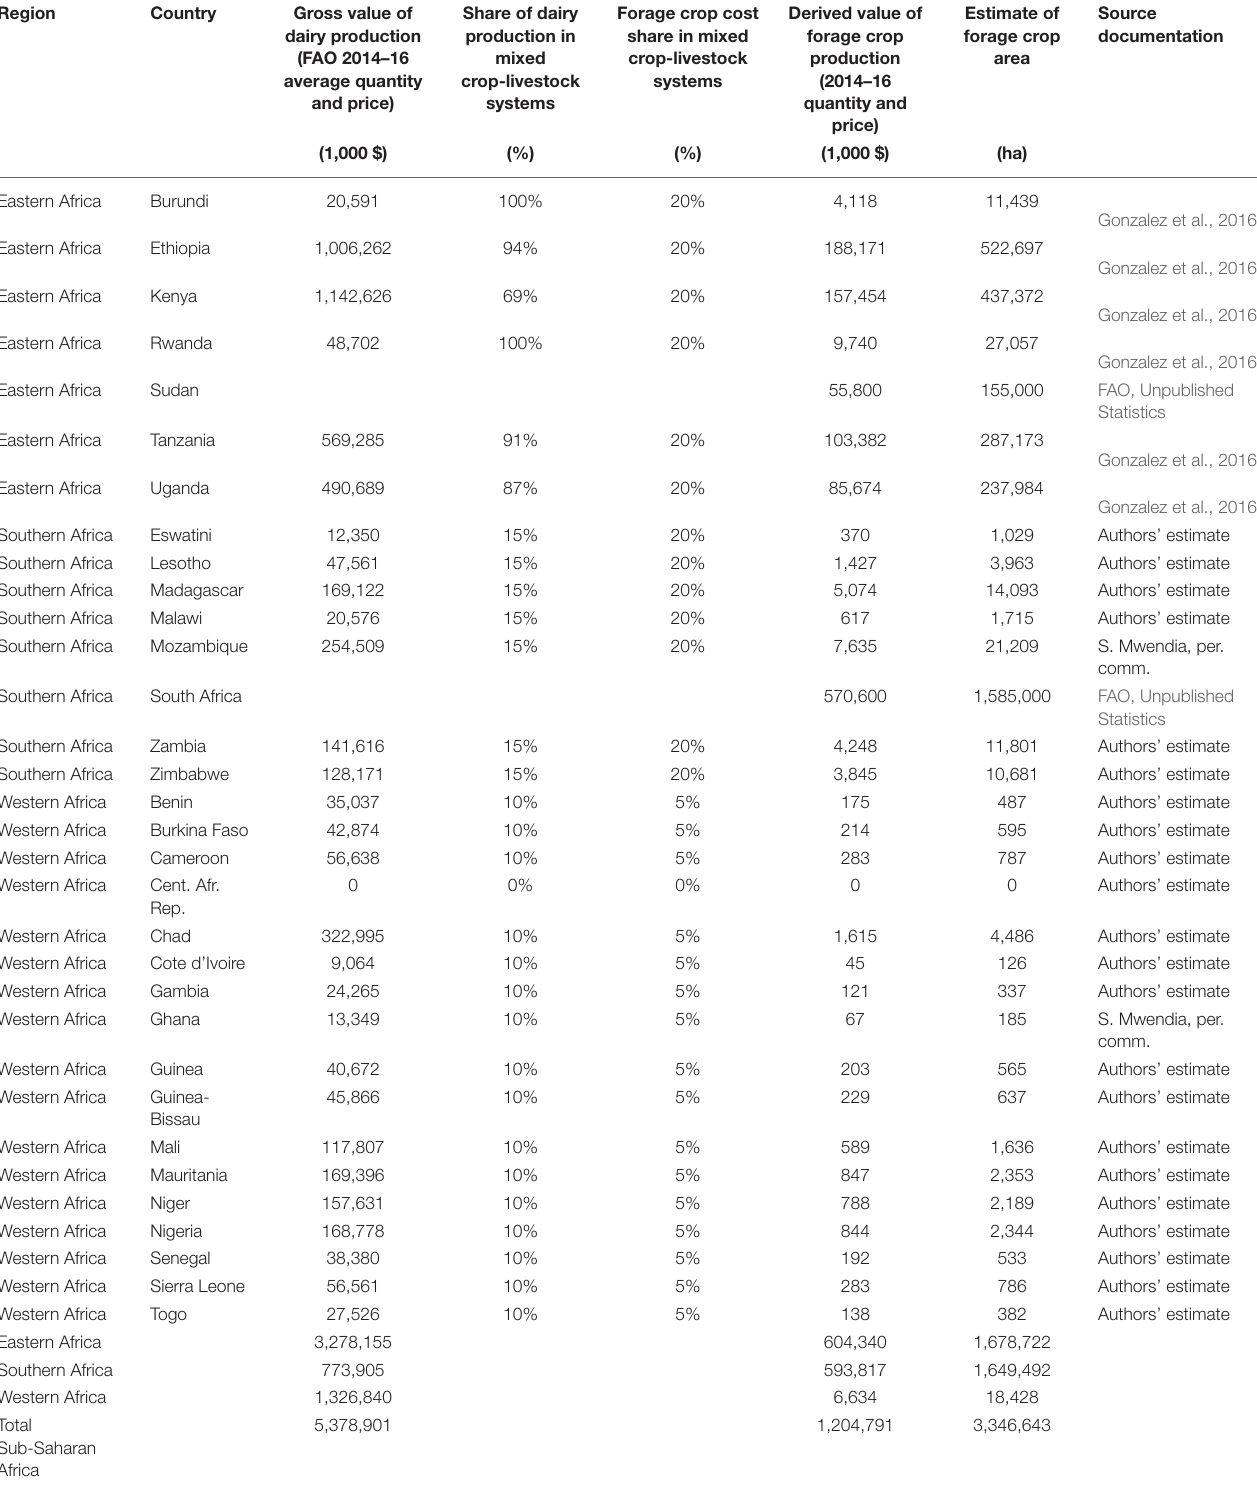
TABLE 2 | Estimates of the area and value of cultivated forage crops in Sub-Saharan Africa. Region Country Gross value of dairy